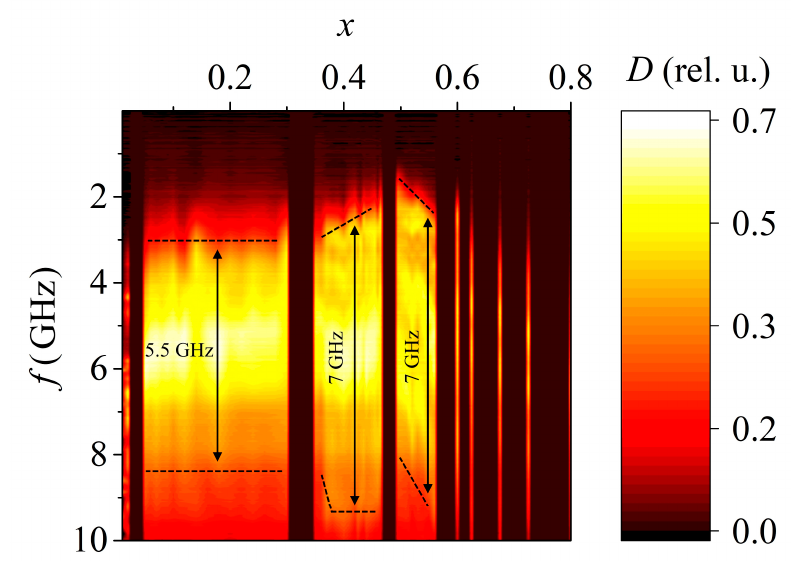
Figure 7. Dependence of the absorption coefficient on the frequency and composition of the PZT system SS samples. The dashed line marks the approximate boundaries of the frequency band with a relatively high level of absorption (more than 40%). Some SS samples were missing so there are gaps in the absorption coefficient diagram.